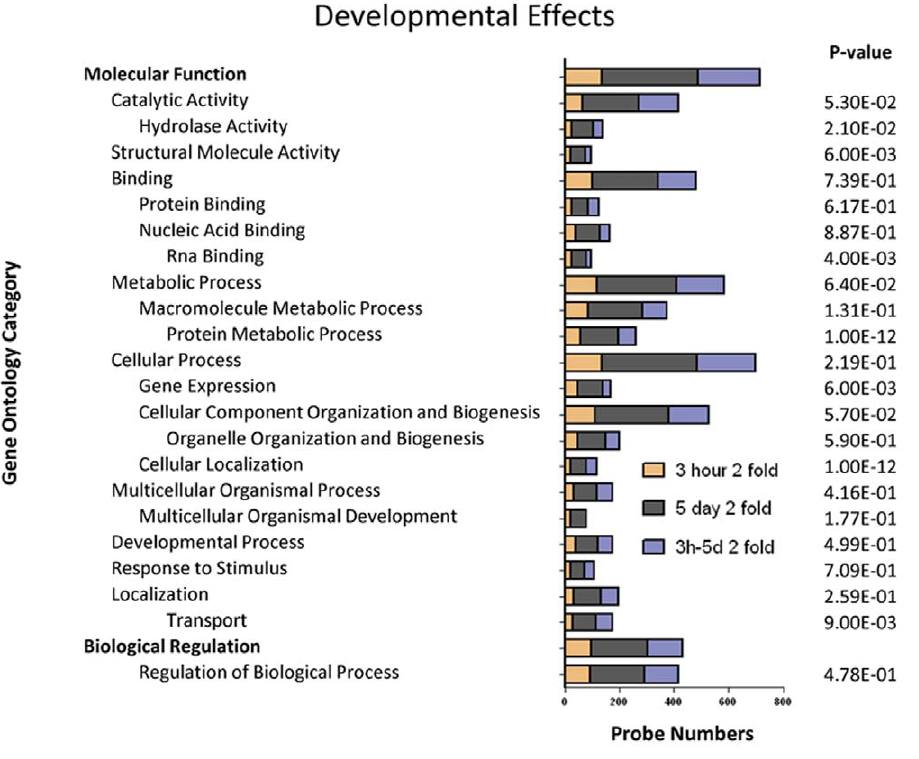
Figure 2. Major gene ontology categories up-regulated during schistosomula transformation. Gene ontologies of up-regulated genes during the transformation of S. mansoni cercariae to 3 h schistosomula, cercariae to 5 day schistosomula, and from 3 h to 5 day schistosomula. The P-value indicates the significance of the gene ontology category based on the number and degree of differentially expressed genes within each category. Categories with a P-value # 0.05 were deemed significant; to show the position of these sub-categories within the GO tree hierarchy, parent categories with a P-value . 0.05 were also included. Categories with P-value . 0.05 may indicate that only a small percentage of the genes were differentially